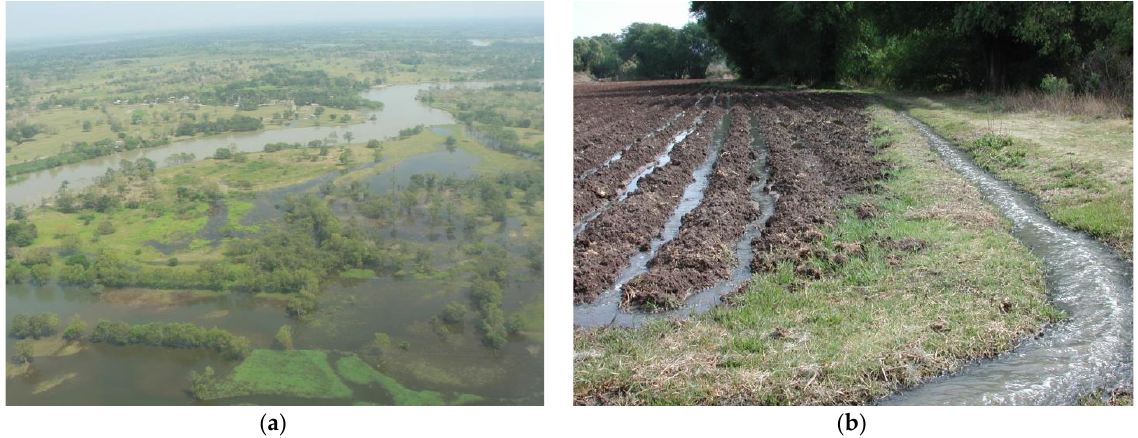
Figure 1. Watershed upstream. ( a ) The river flowing out of its course in a curve; ( b ) crop fields.